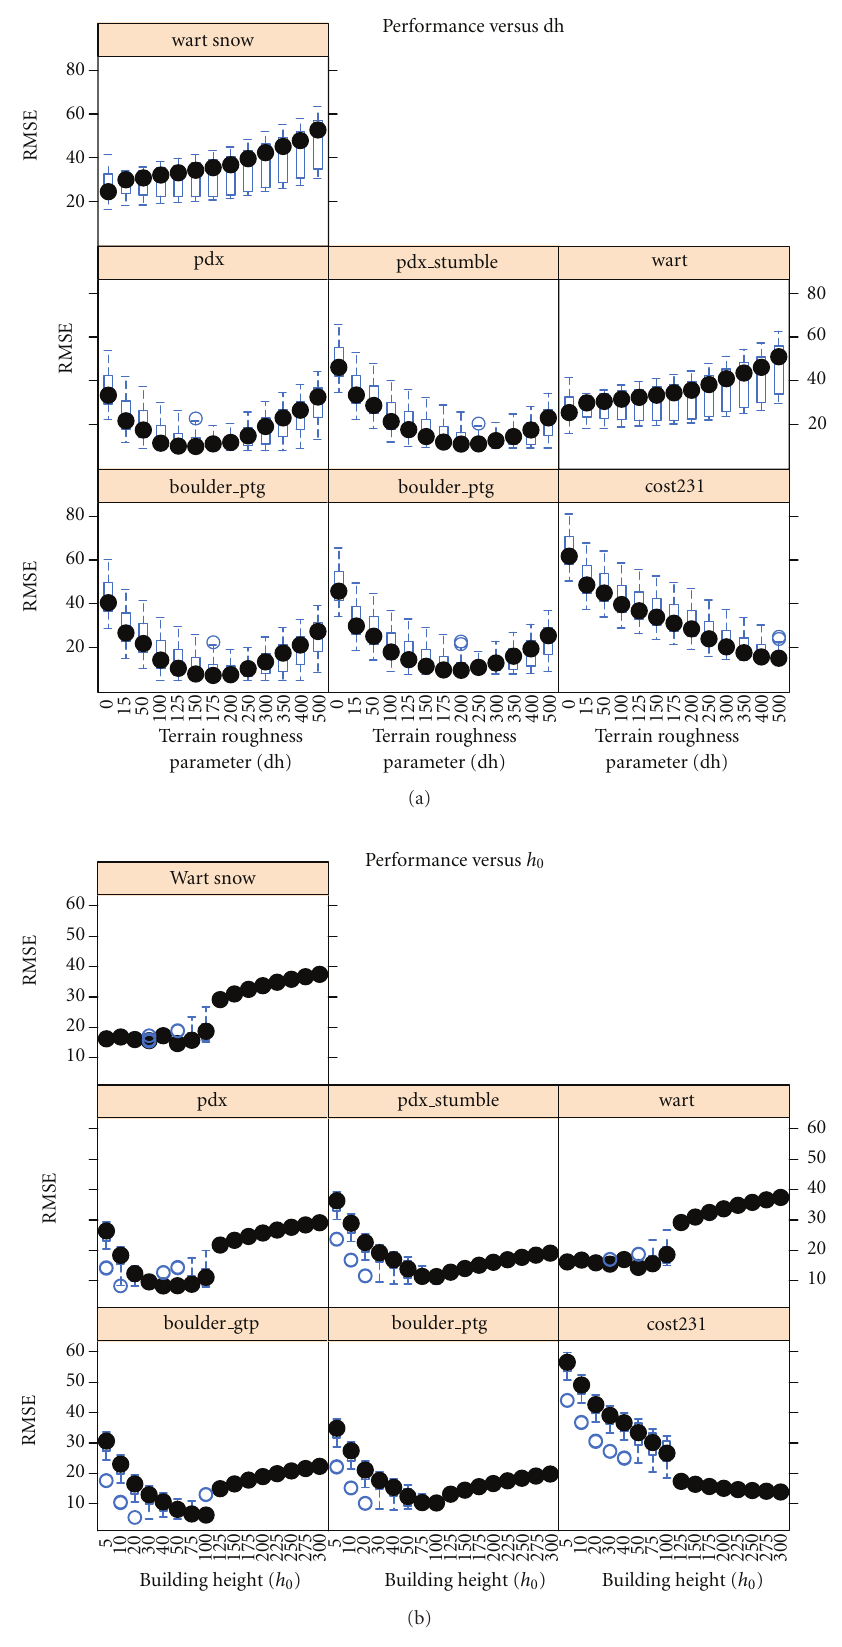
Figure 10: Explicit parameter fitting for the Allsebrook and Flat-Edge model